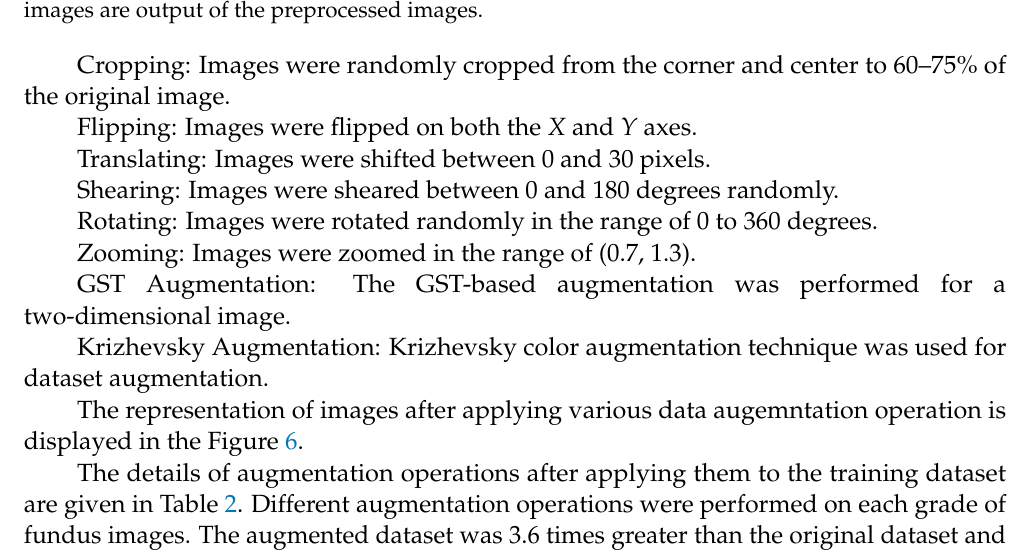
Figure 5. Some examples of adding weighted Gaussian blur to the retinal images, which is employed to reduce noise and increase image structure. First row are original fundus images, and second images are output of the preprocessed images.